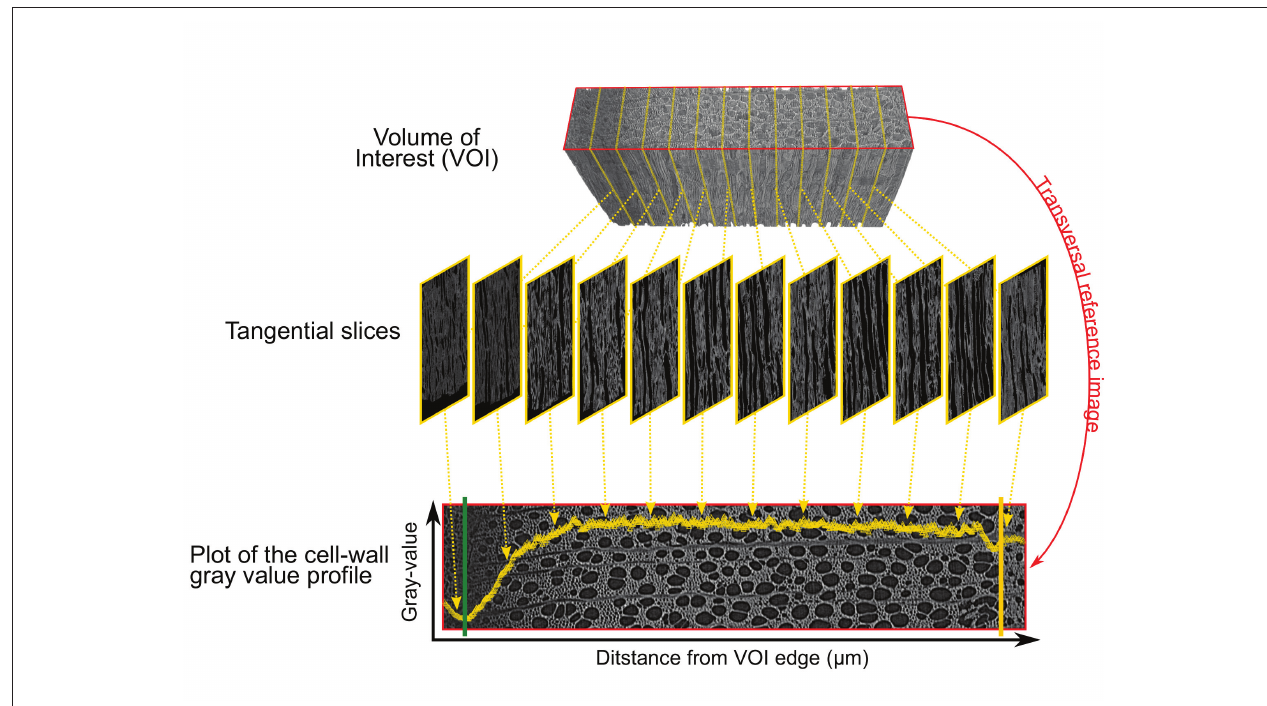
FIGURE 3 | Plot of the cell wall gray profile. The volume of interest (VOI) containing the inner layers of the phloem, the cambium, and the forming xylem growth ring (top) is sliced tangentially (middle). Averaging the cell wall gray values of each tangential slices results in a cell wall gray value profile plotted over the transversal reference image (bottom). The reference image is in the red frame (top and bottom image), the cambium and previous ring boundary are highlighted by the green and yellow lines